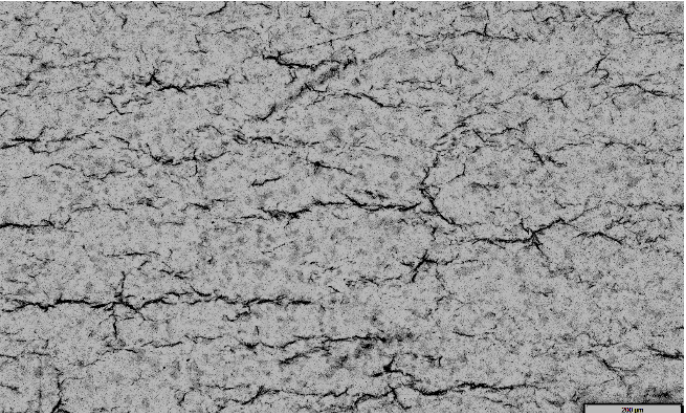
Figure 1. Circumferential hydrides (dark) in Zircaloy-4.